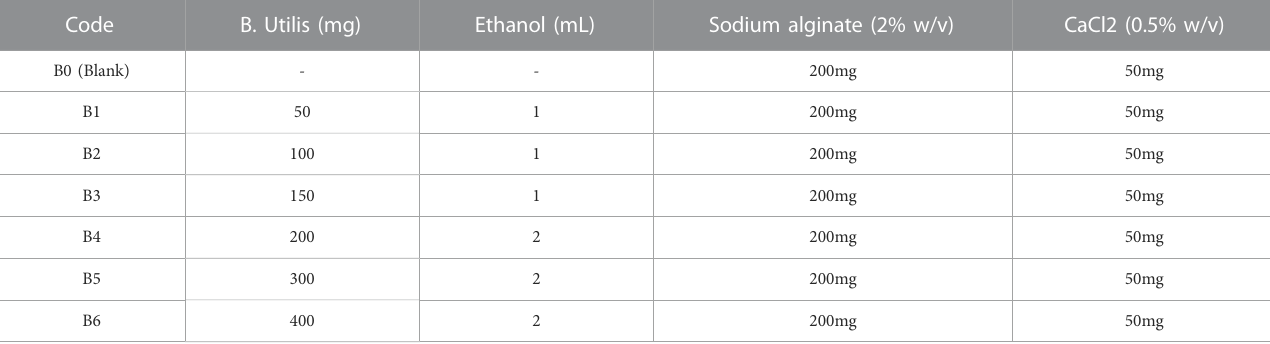
TABLE 1 Composition of sodium alginate hydrogel fi lms. Code B. Utilis